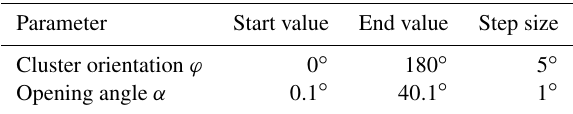
Table 2. Horizontal-cluster CPO model parameters. Table 3. Best-fitting CPO model parameters and uncertainties in- formed by VSP